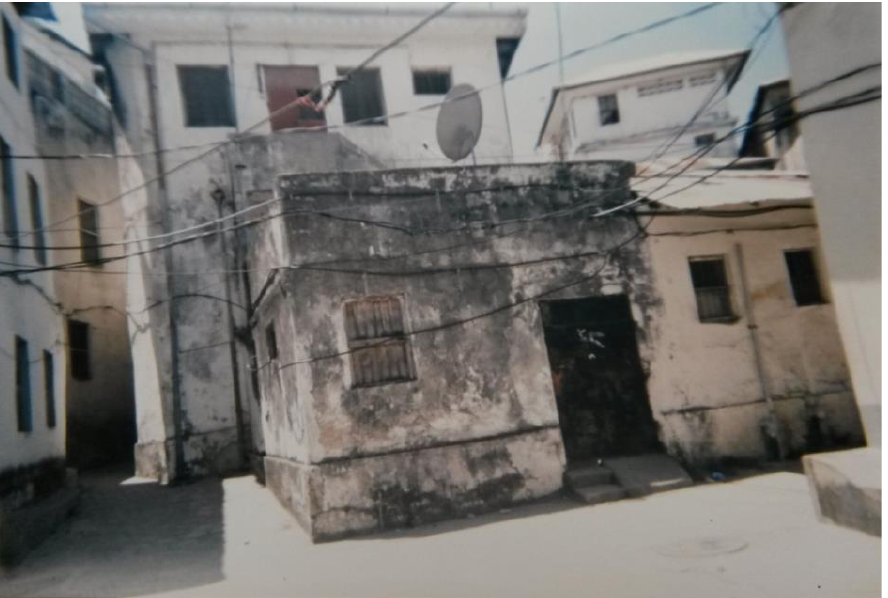
Figure 4. ‘This picture shows that the house is in a clean environment [mazingira safi]’. (Habiba, 12 years old)